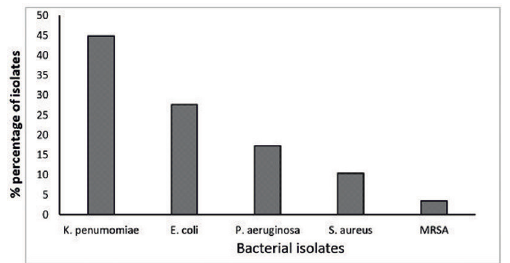
Fig. 1. Percentages (%) of identified MDR-bacteria from clinical